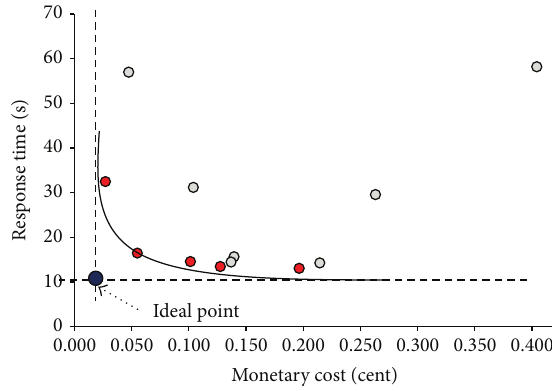
Figure 2: Paretooptimal curve for the response time and monetary cost of TPC-H Q3 with different virtual resource configurations and query plans. Table 1: Response time and monetary costs of TPC-H query 3 (QP with 6 different virtual resource